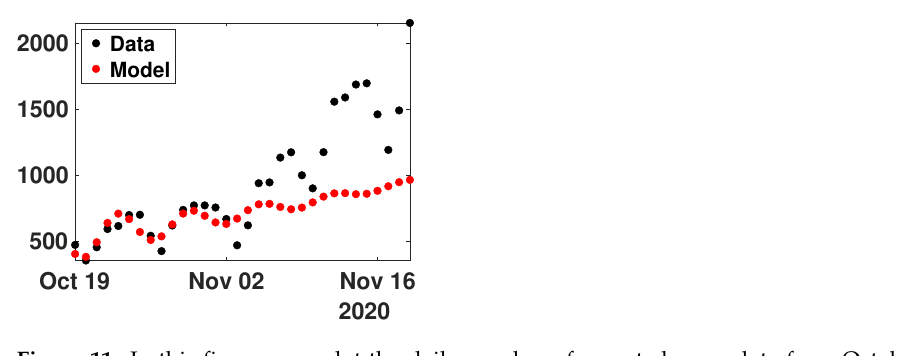
Figure 11. In this figure, we plot the daily number of reported cases data from October 19 and November 19, 2020 (black dots) and from model (24) and (25) with the values of R 0 ( d ) obtained in Figure 10c (red